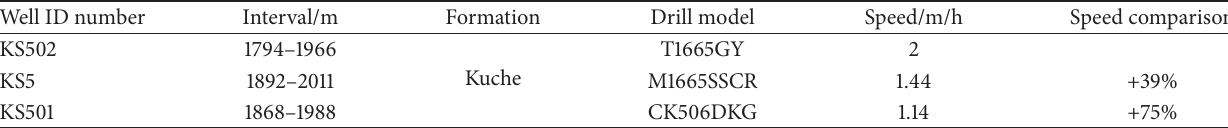
Table 4: Comparison of mechanical drilling speed of KS502 with adjacent